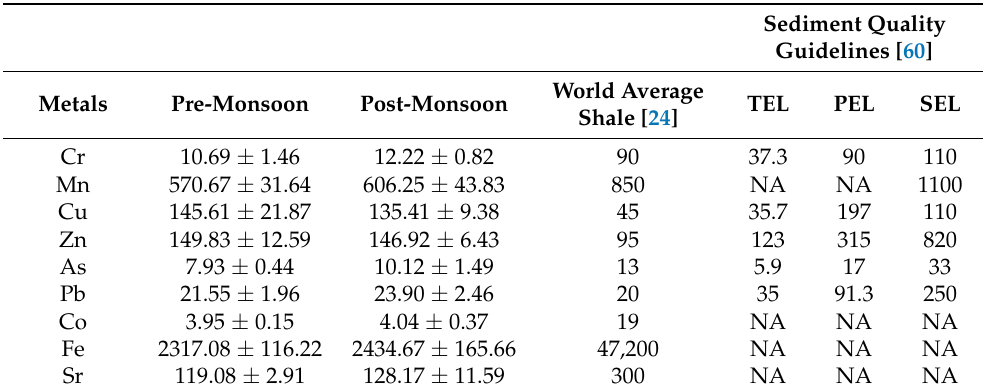
Table 3. Average concentration (mg/Kg) of metals in the sediment sample, n =